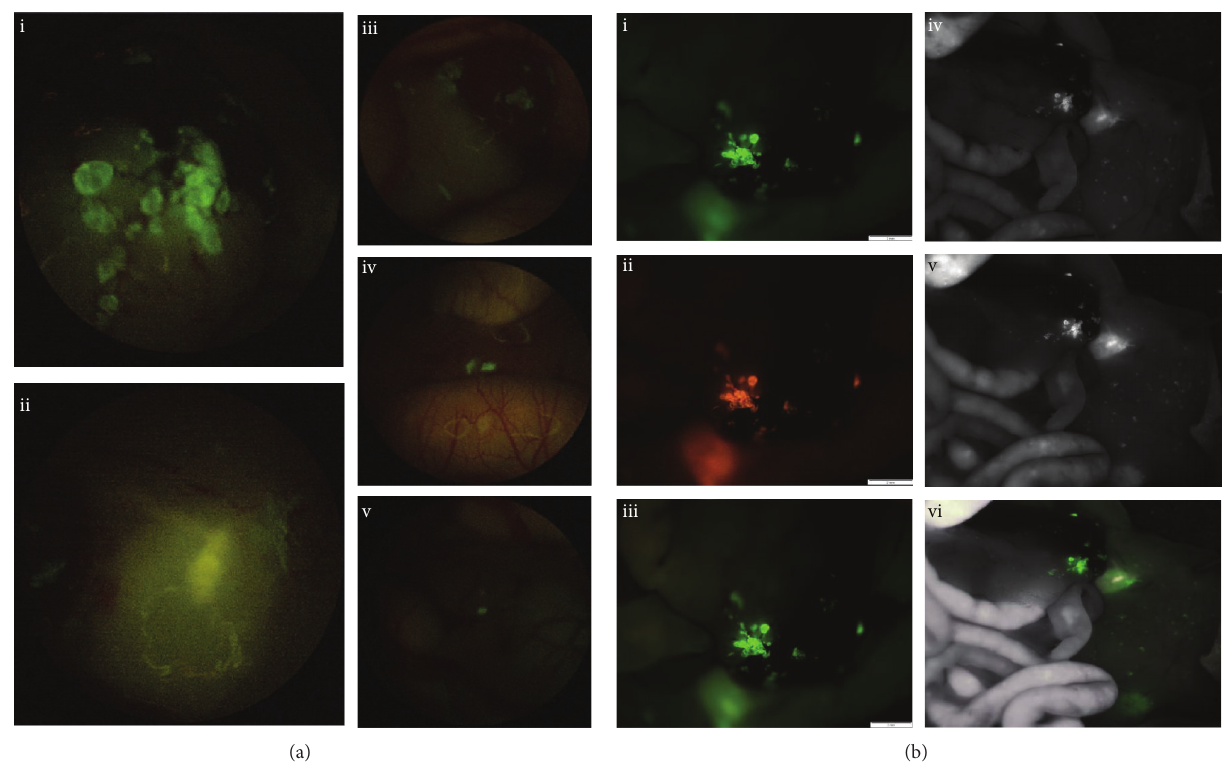
Figure 6: Orthotopic mouse model of BxPC-3 human pancreatic cancer dual labeled with anti-CEA Alexa 488 and 555. (a) Laparoscopic images of representative mouse specimen with BxPC-3 dual labeled with anti-CEA Alexa 488 and 555. The combination of red and green fluorophores creates a significantly brighter fluorescence signal without compromising background illumination. (i–iii) are laparoscopic images of the left upper quadrant. (iv) and (v) are laparoscopic images of metastatic tumor deposits hidden within the mesentery of the mouse. These deposits were virtually undetectable under BL. (b) (i–iii) are intravital OV-100 images of the same mouse specimen under (i) GFPa filter (excitation 460–490; emission 510–550), (ii) RFP filter (excitation BP 535–555; emission 570–623), and (iii) GFP (excitation 460– 490; emission 510F) filters. The bottom image (iii) corresponds to GFP bandwidth through which fluorescence laparoscopy is viewed. (iv–vi) are the corresponding intravital Maestro images. (iv) and (v) are spectral unmixing images of the (vi) compositive image obtained through (iv) GFP and (v) RFP filter sets, respectively. These images confirm the dual labeling of BxPC-3 tumor with Alexa 488 and 555